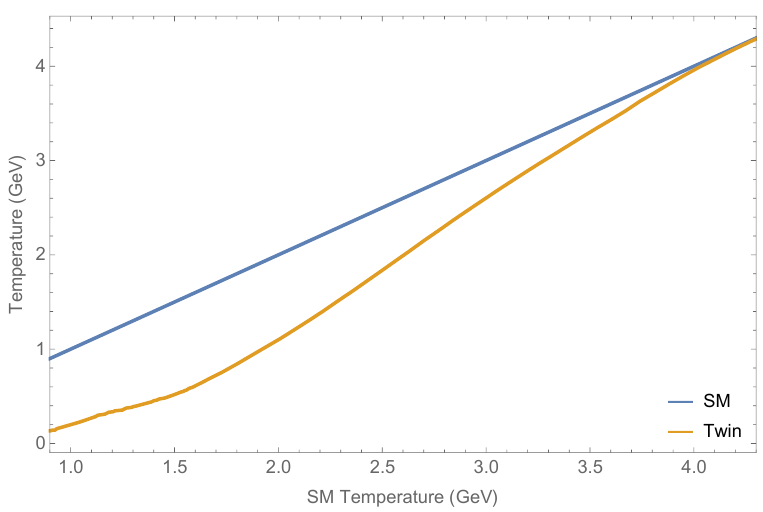
Figure 3 . Minimum temperature of the twin sector that will not be heated by interactions with a hotter SM plasma, as a function of SM temperature, for f=v = 4. Also shown is the SM temperature, for